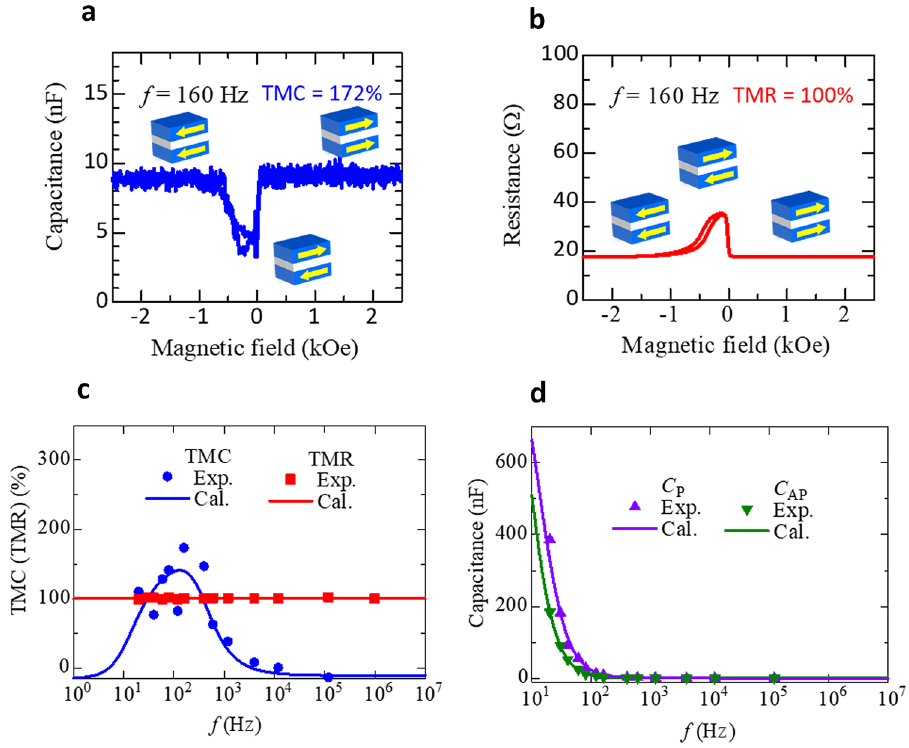
Figure 2. TMC and TMR at zero bias voltage. ( a ) TMC and ( b ) TMR transfer curves of an MgO-based MTJ sample at a frequency of 160 Hz. ( c ) Frequency dependence of TMC and TMR, experimental data and model calculations. Note the strong frequency dependence of TMC and independence of TMR. ( d ) The capacitance C P(AP) versus frequency in the P(AP) configuration. The solid points are experimental data and the solid lines represent the calculation results based on Debye-Fröhlich model as described by Eq.